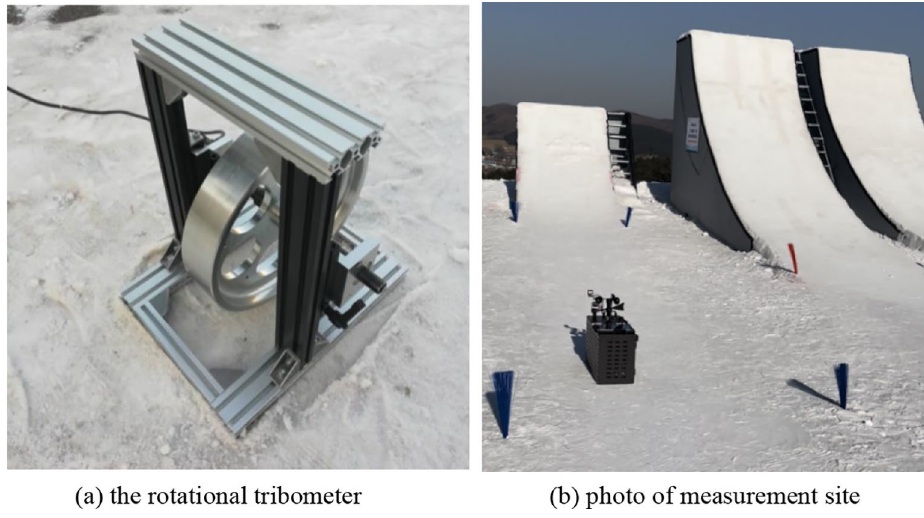
Figure 3. Overall structure of the measuring